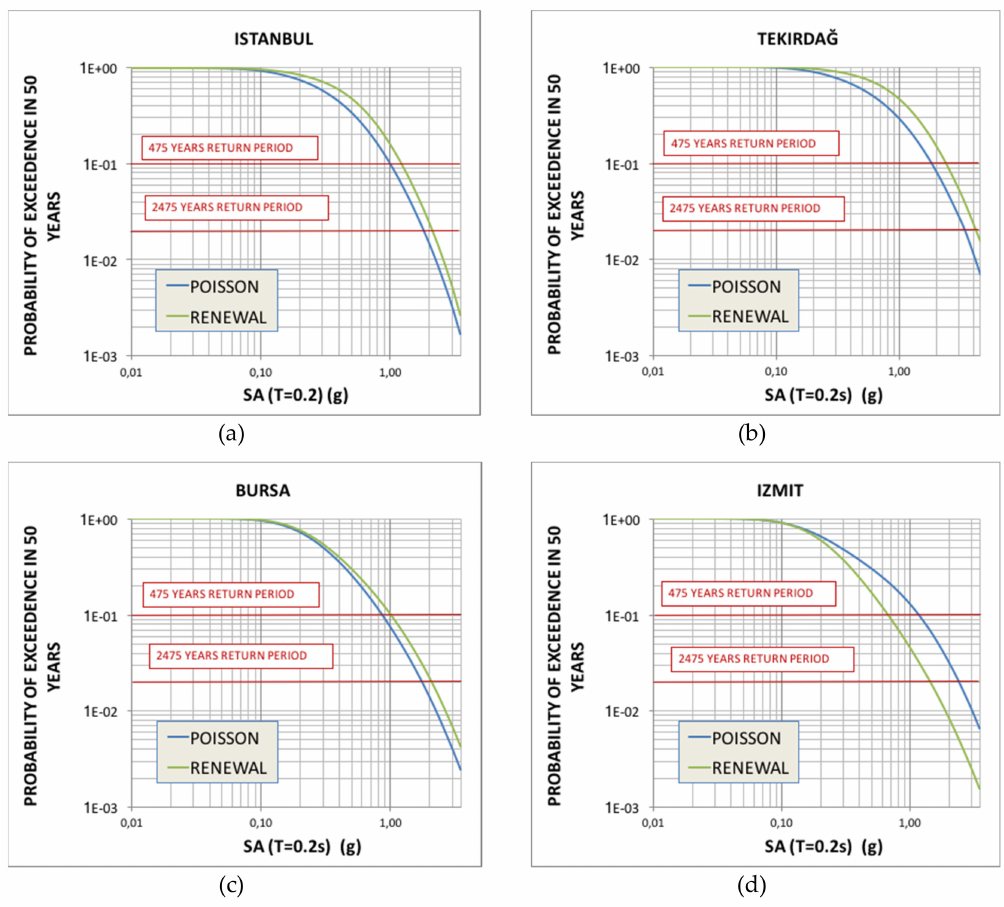
Figure 24. Five percent damped spectral acceleration (SA) at T = 0.2 s hazard curves for ( a ) Istanbul, ( b )Tekirda˘g, ( c )Bursa, and( d )Izmit(Kocaeli)obtainedfromPoissonandrenewalmodels, bothcombined with smoothed seismicity at the background.